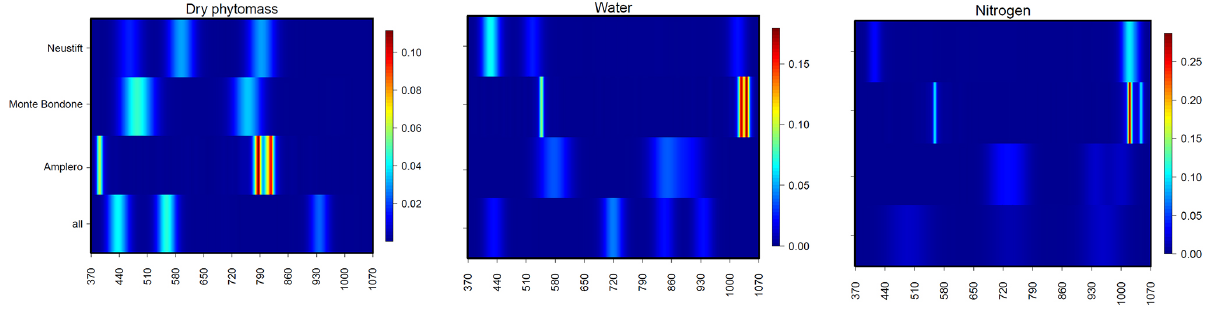
Figure 10. Results of the GA–rF method for band selection for Amplero, Neustift, Monte Bondone and all sites pooled for dry phytomass, water and nitrogen